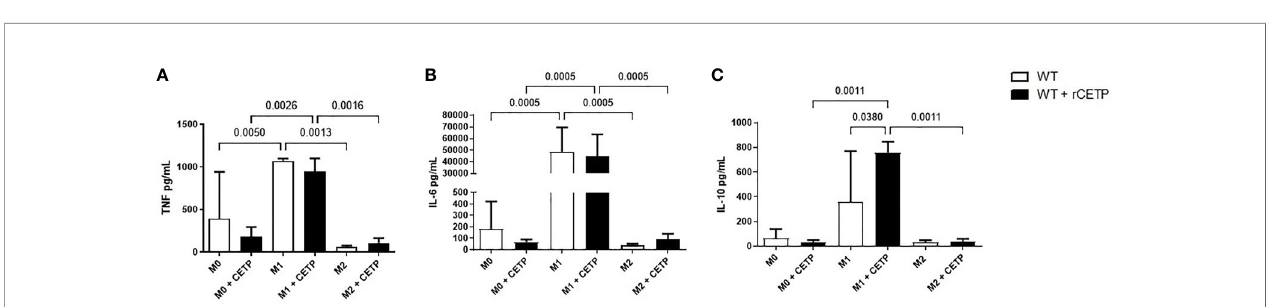
FIGURE 8 | Cytokine secretion in cell culture medium. Bone marrow-derived macrophages from WT mice, unpolarized (M0), or stimulated to M1 (with 5 ng/ml IFNg + 50 ng/ml LPS), or to M2 (with 10 ng/ml IL-13 + IL-4) in the absence (control) or presence of recombinant human CETP (1 µg/ml) for 24 h. TNF (A) , IL-6 (B) and IL-10 (C)